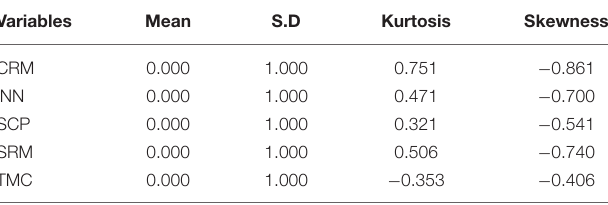
TABLE 2 | Descriptive statistics of all study variables ( N =